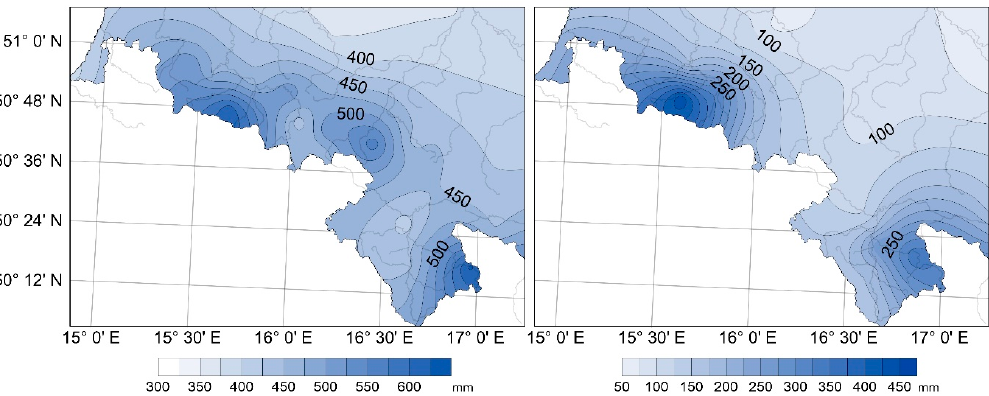
Figure A1. Graphical illustration of Ward’s method—the tree diagram with the assigned types (dates indicate culmination days of floods belonging to each group).